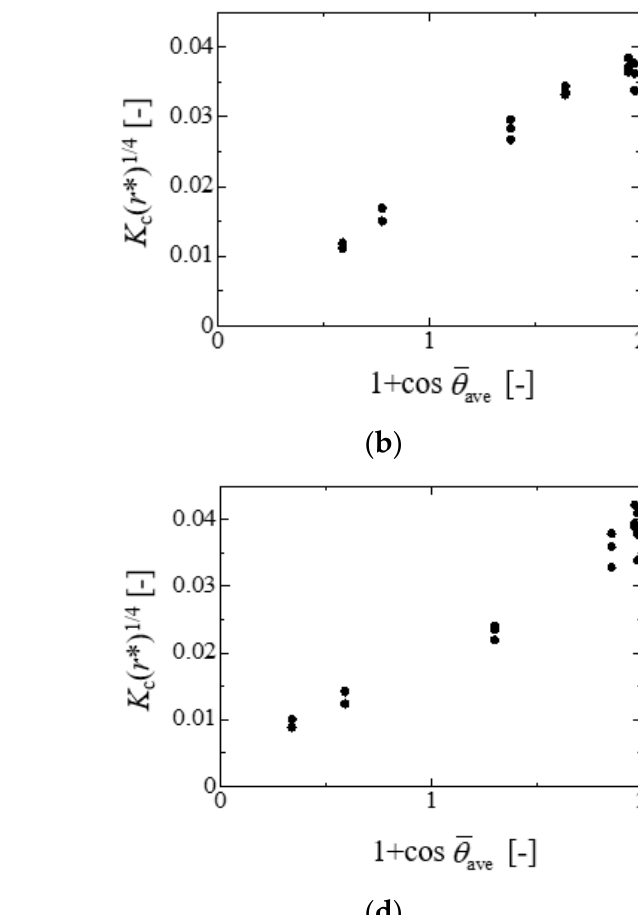
θ is calculated by ave